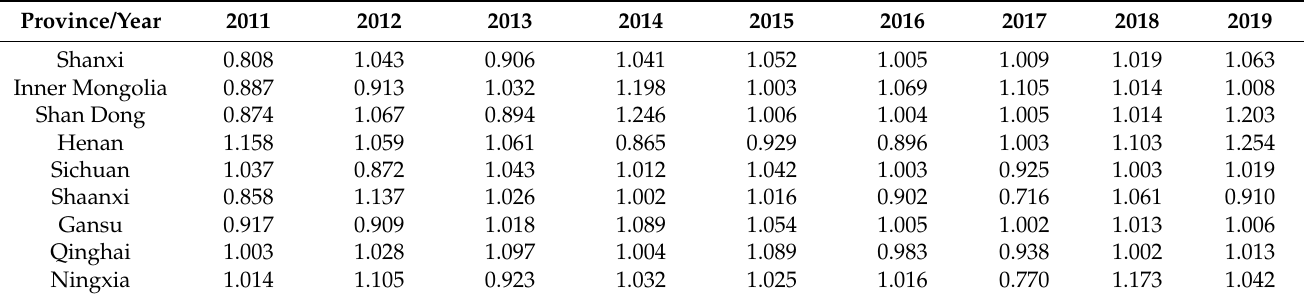
Table 2. Calculation results of high-quality development efficiency of provinces in the Yellow River Basin.